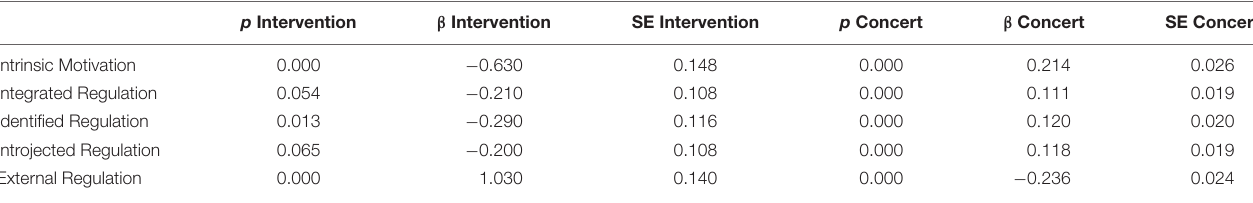
TABLE 1 | Effect of intervention and concert on